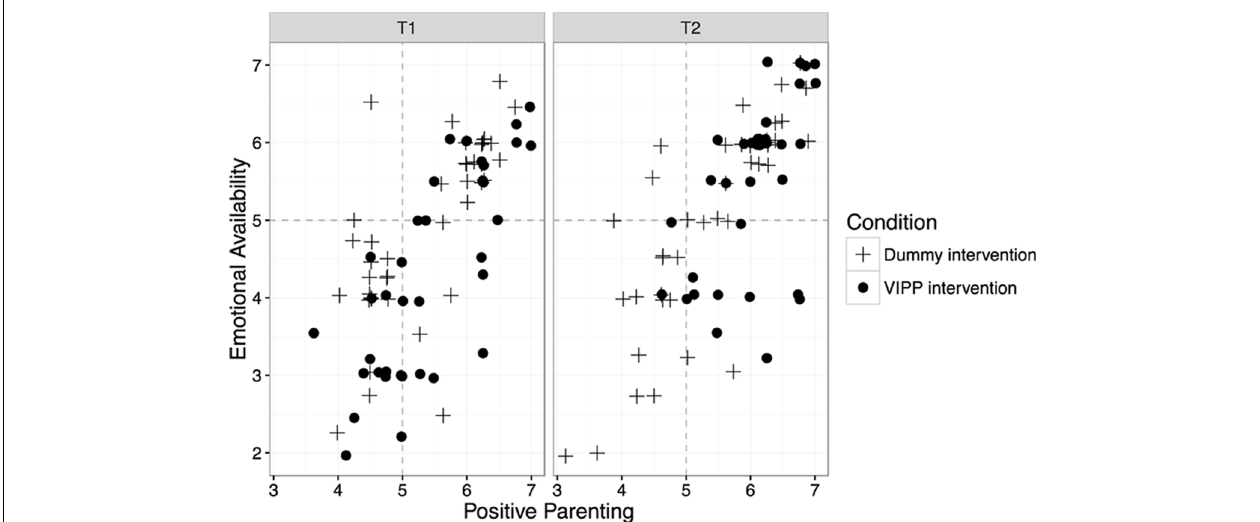
FIGURE 3 | Associations between maternal positive parenting scores and children’s emotional availability scores in the VIPP and dummy intervention condition at the pre-intervention assessment (T1, box on the left) and at the post-intervention assessment (T2, box on the right). Each point in the figure represents a mother–child